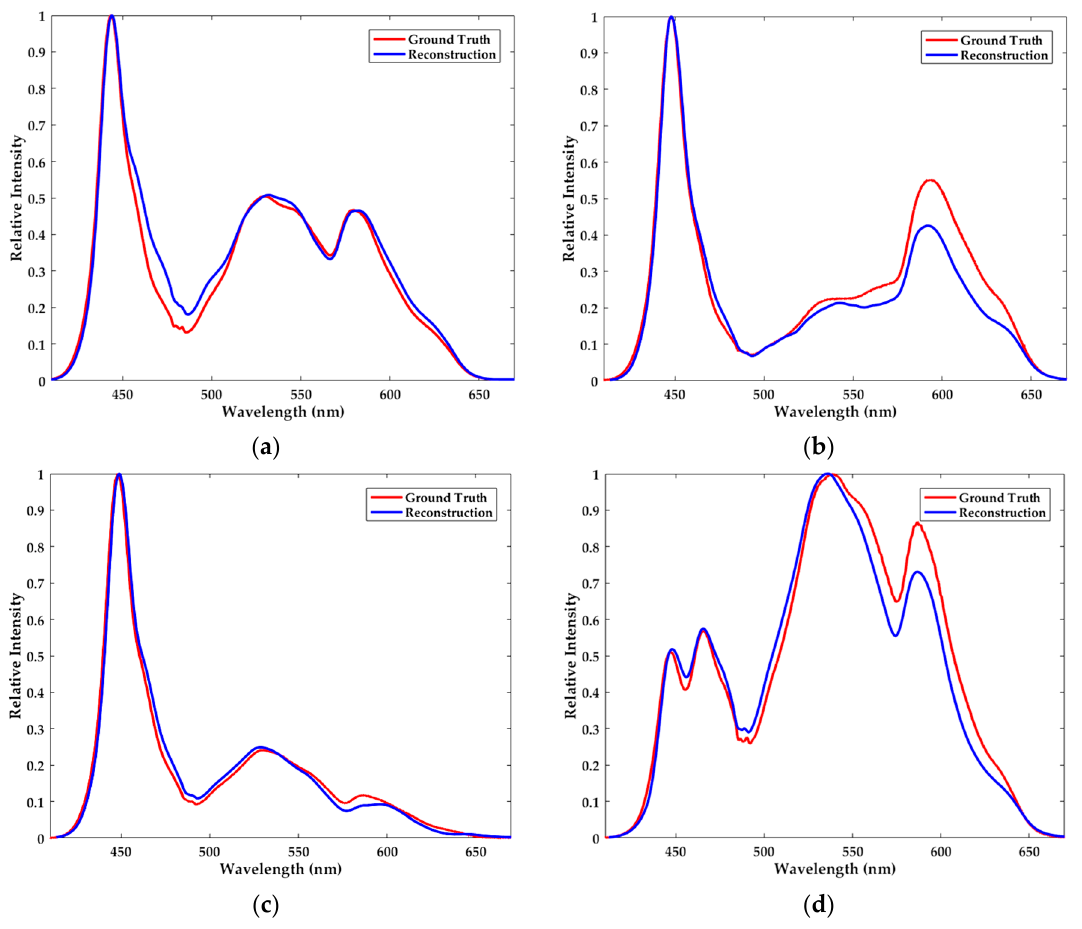
Figure 6. The ground truth spectra (red) and the reconstructed spectra (blue) of ( a ) LED, ( b – d ) LED with different additional filters. We combine the l 1 -norm minimization with the dictionary learning to reconstruct the spectra.